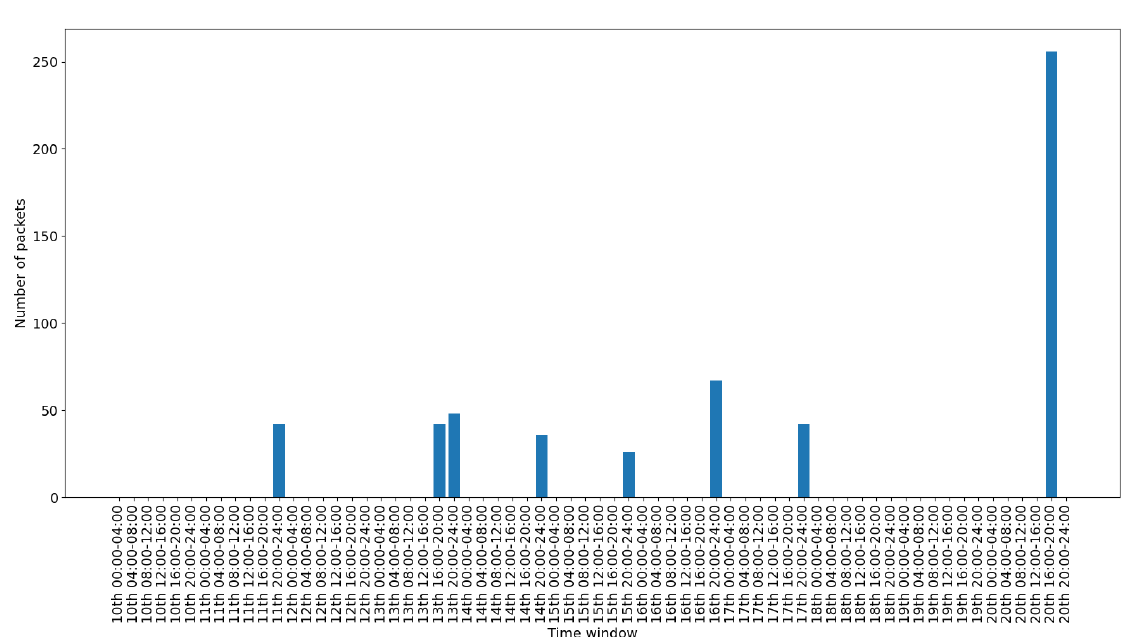
Figure 11. Bluetooth data packets time